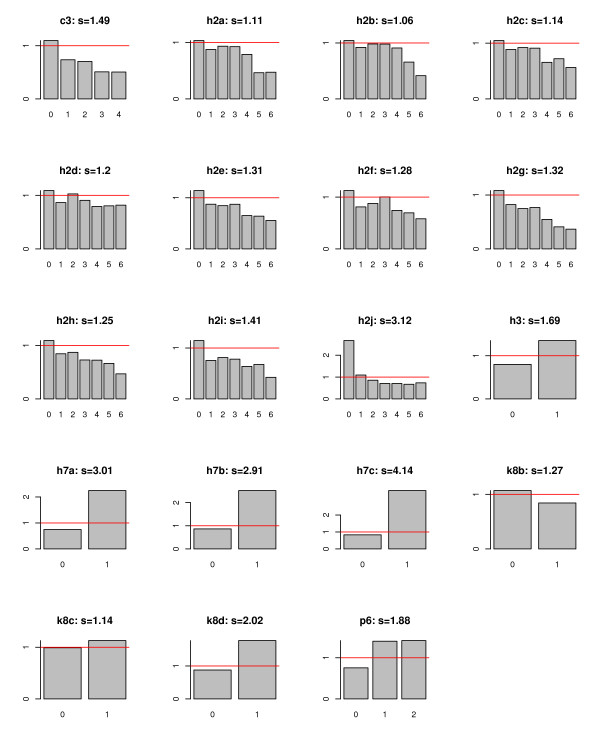
Ratio profiles for all 19 covariates, together with their ratio profile scores.